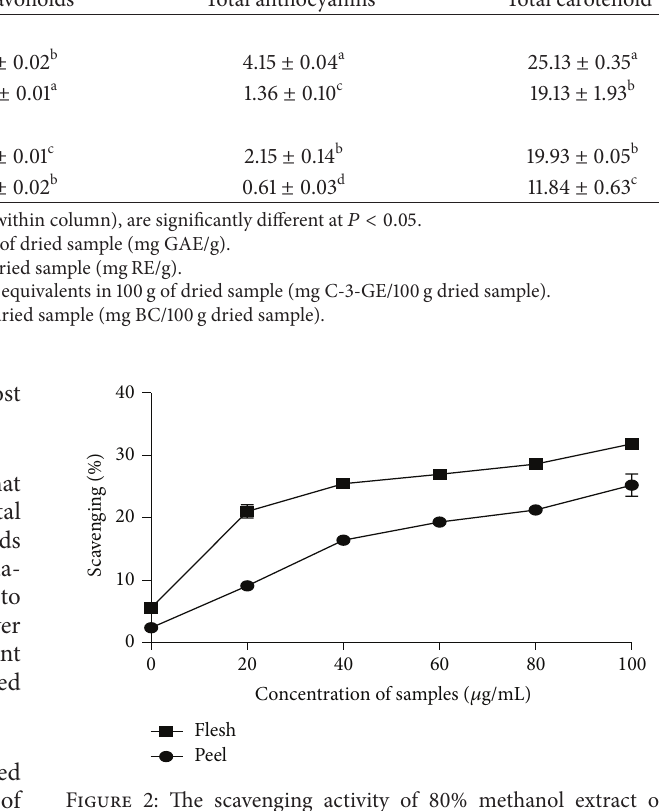
Figure 2: The scavenging activity of 80% methanol extract of differentpartsof C.betacea assayedbyDPPHfreeradicalscavenging method ( 𝑛 = 3